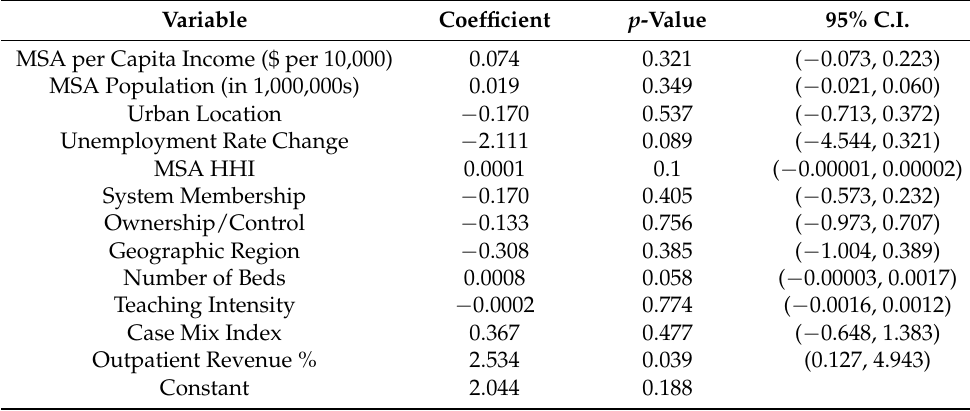
Table 3. Regression Model Results for Study Aim 1, Days Cash on Hand (Dependent